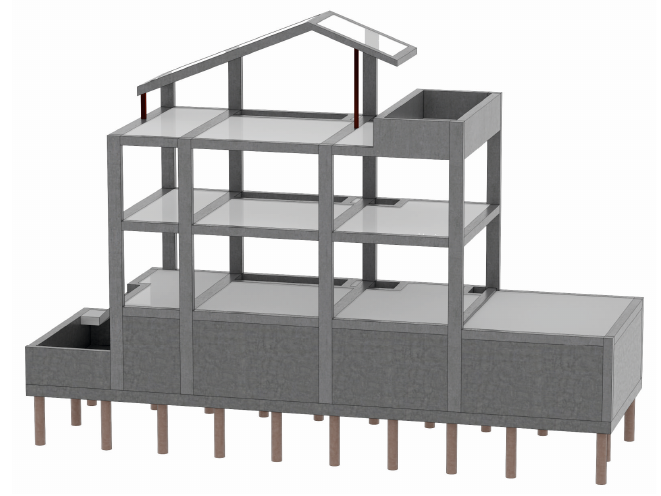
Figure 2. 3D view of the structural baseline design (REF).